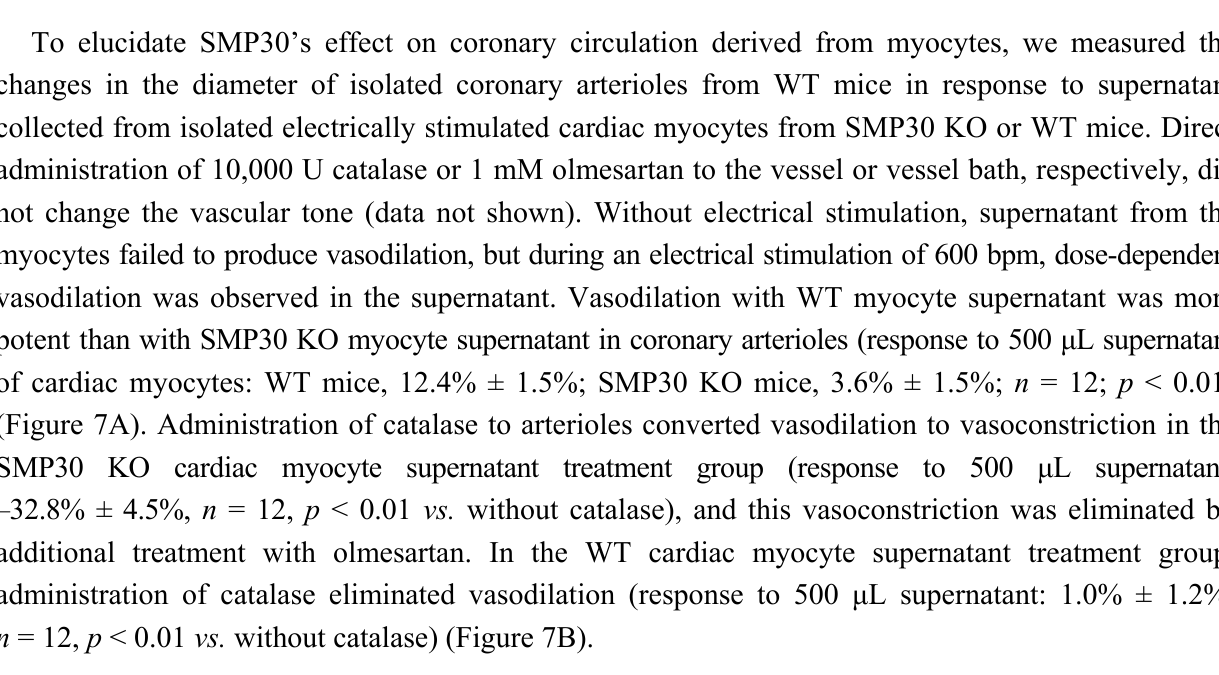
Figure 7. Vasodilation induced by the supernatant from stimulated cardiac myocytes. The supernatant of electrically stimulated cardiac myocytes dilated WT coronary arterioles dose-dependently. Vasodilation with WT cardiac myocyte supernatant was more potent compared to that with SMP30 KO cardiac myocyte supernatant ( A ) Administration of olmesartan to coronary arterioles enhanced vasodilation in the SMP30 KO cardiac myocyte supernatant treatment group (500 μ L of supernatant). Administration of catalase to coronary arterioles converted vasodilation to vasoconstriction in the SMP30 KO cardiac myocyte supernatant treatment group and eliminated vasodilation in the WT cardiac myocyte supernatant treatment group. Treatment with olmesartan in addition to catalase in the vessel bath eliminated vasoconstriction in the SMP 30 KO cardiac myocyte supernatant treatment group; ( B ) Values are expressed as the mean ± S.E.M. n = 12 each, * p < 0.01 vs. without